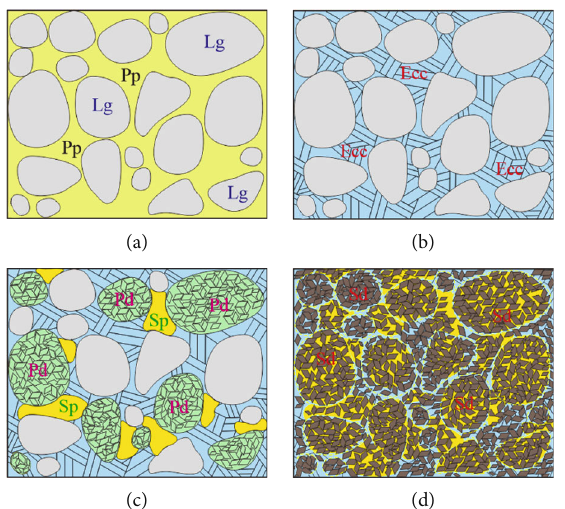
Figure 7: Schematic diagram of the formation mechanism of intercrystalline pore-type dolostone reservoir (after [18]) (Pp = primary intergranular pore; Lg = limestone grain; Ecc = early calcite cement; Pd = powdery intercrystalline dolomite; Sp = secondary pore; Sd = fi ne-crystal